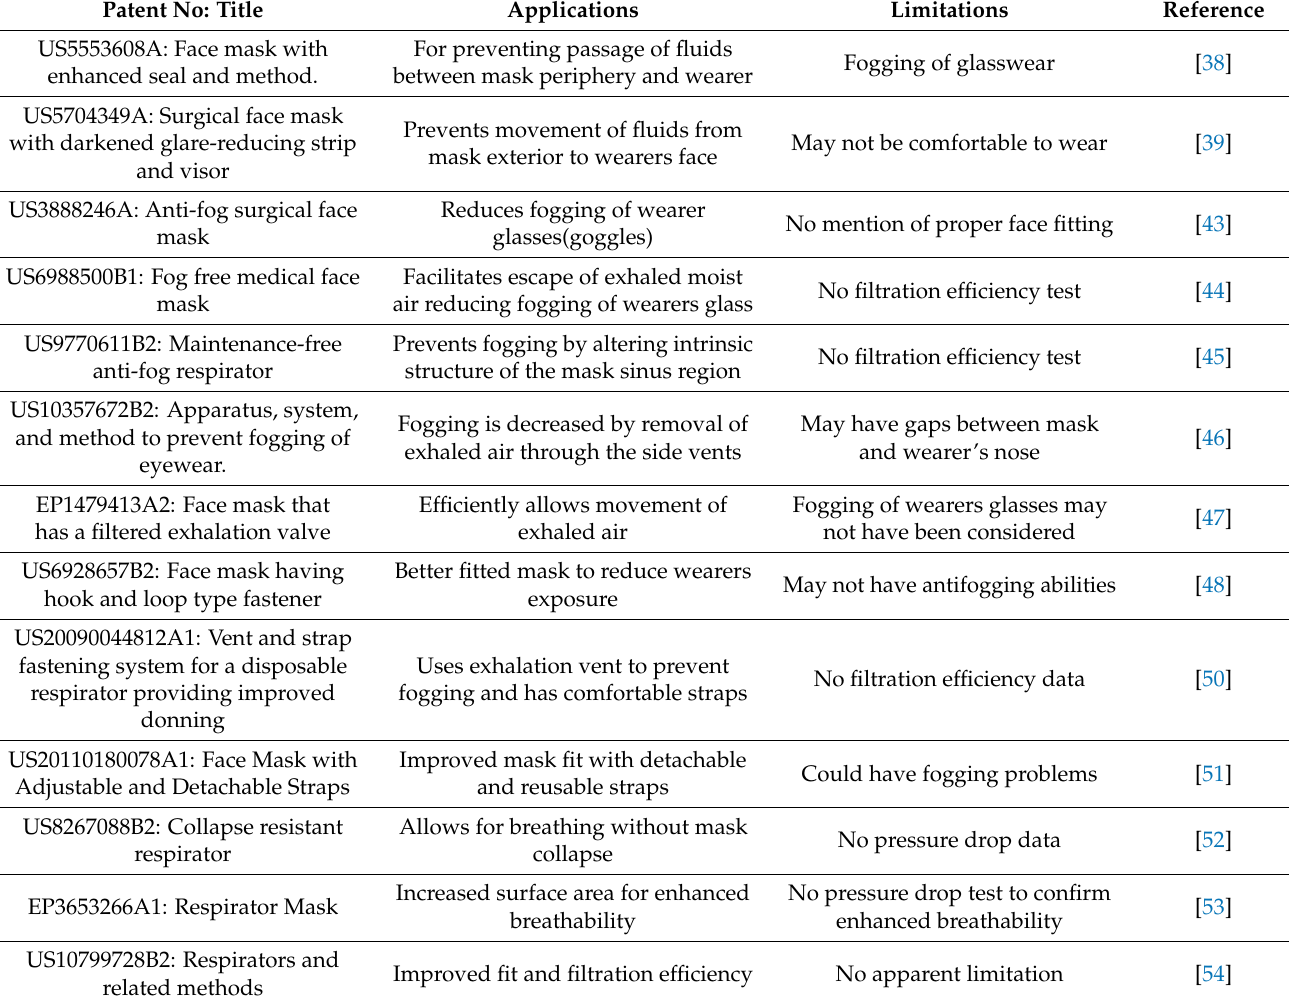
Table 1. Applications and limitations of reviewed